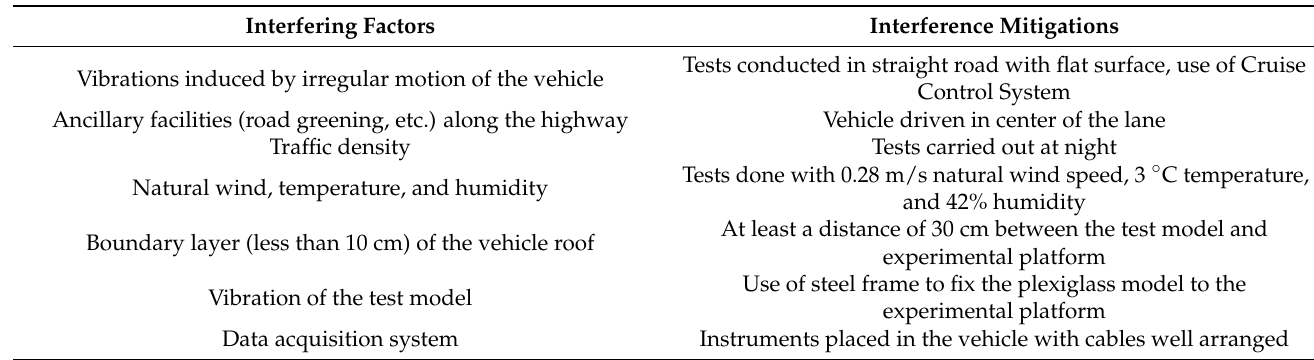
Table 3. Mitigations to cancel interferences for the transiting